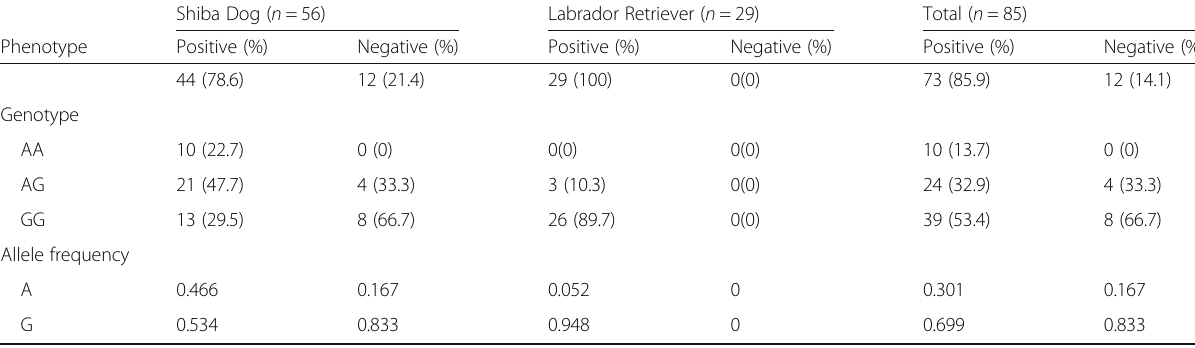
Table 2 Correlation of the CMAH gene at the c.554A > G locus in dogs with presence or absence of Neu5Ac expression Shiba Dog ( n = 56) Labrador Retriever ( n = 29) Total ( n =